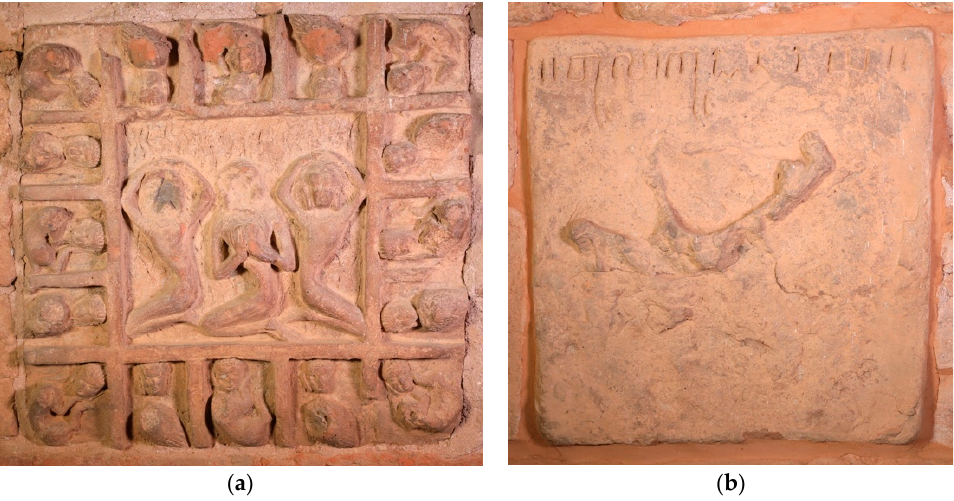
Figure 38. Pagan, Hpetleik Stupa, 11th century. Two hell plaques—one uninscribed, humans protecting their heads, surrounded by tied up bodies awaiting their turn. The second image is badly damaged but reads Tulakutanirayam (false weight hell). ( a ) subtitle, ( b )